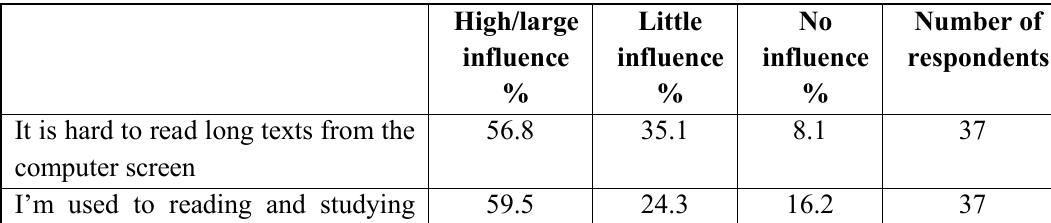
Print versus Digital – Reasons that Influence the Respondents’